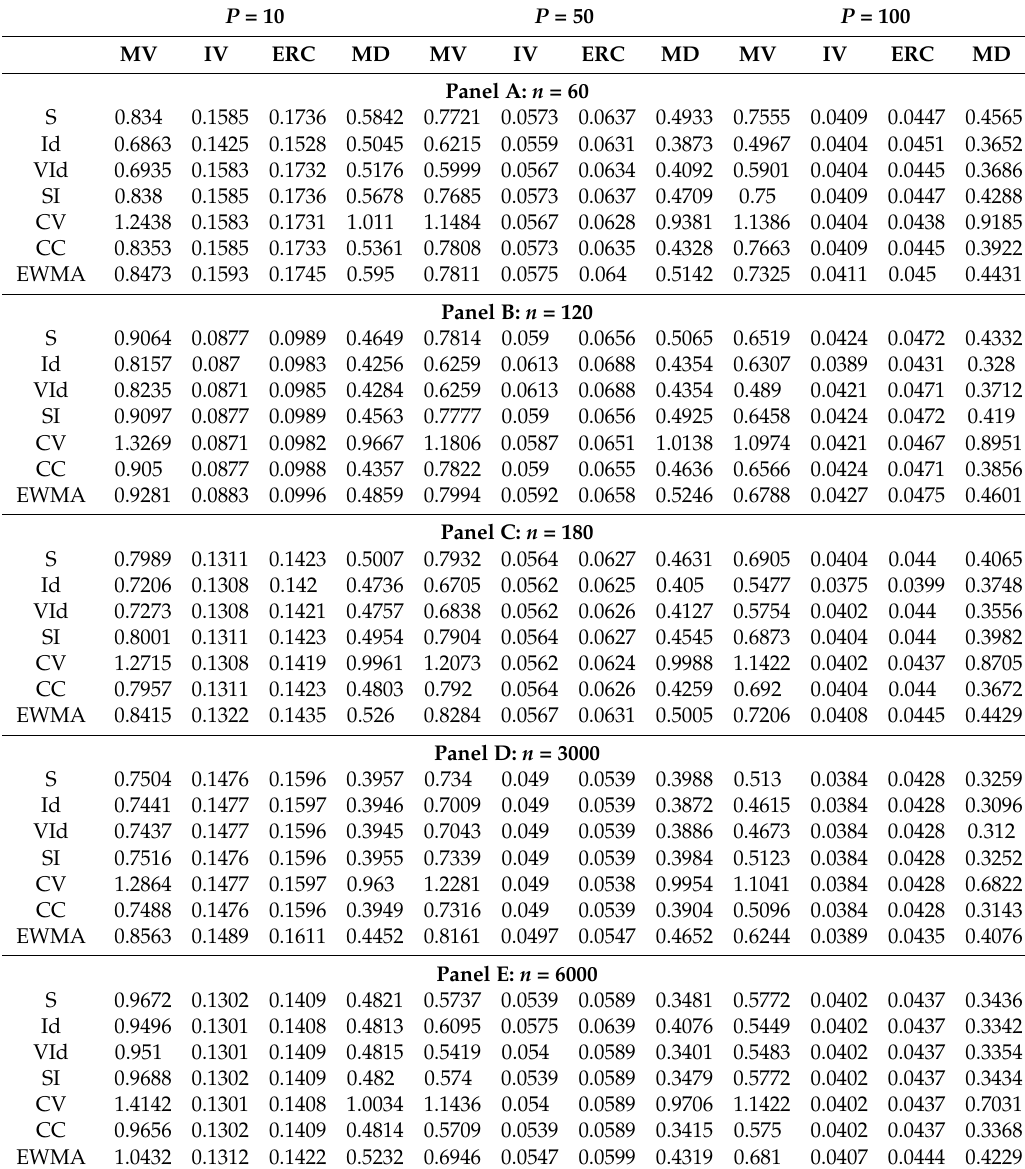
Table 3. Frobenius norm for the portfolio weights. Values are averaged along with the shrinkage intensity (excluding the case δ = 0 ). For each n , the first line reports the Frobenius norm for the sample covariance matrix. Abbreviations in use are: S for sample covariance; Id for identity matrix; VId for Variance Identity; SI for Single-Index; CV for Common Covariance; CC for Constant Correlation and EWMA for Exponentially Weighted Moving